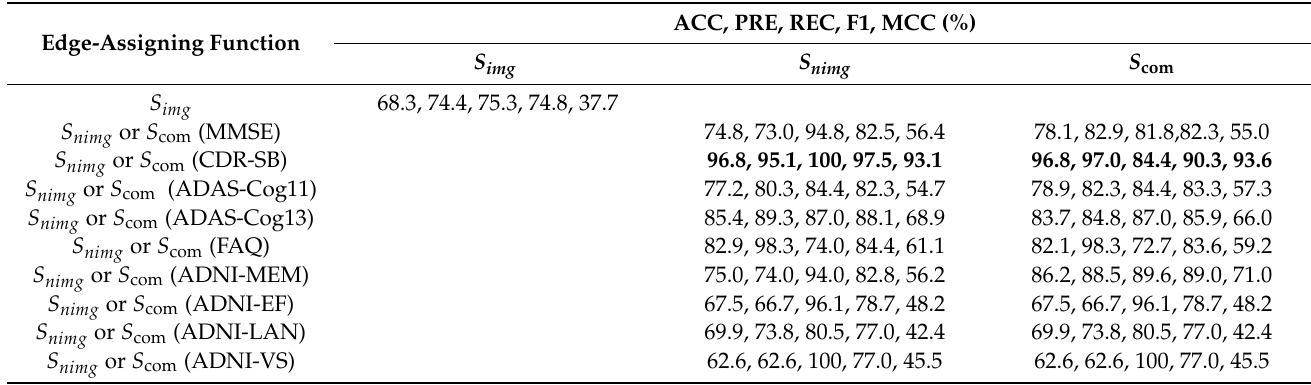
Table 5. GCN model performance under MCI versus CN task on the test data with different edge- assigning functions. The best results are given in